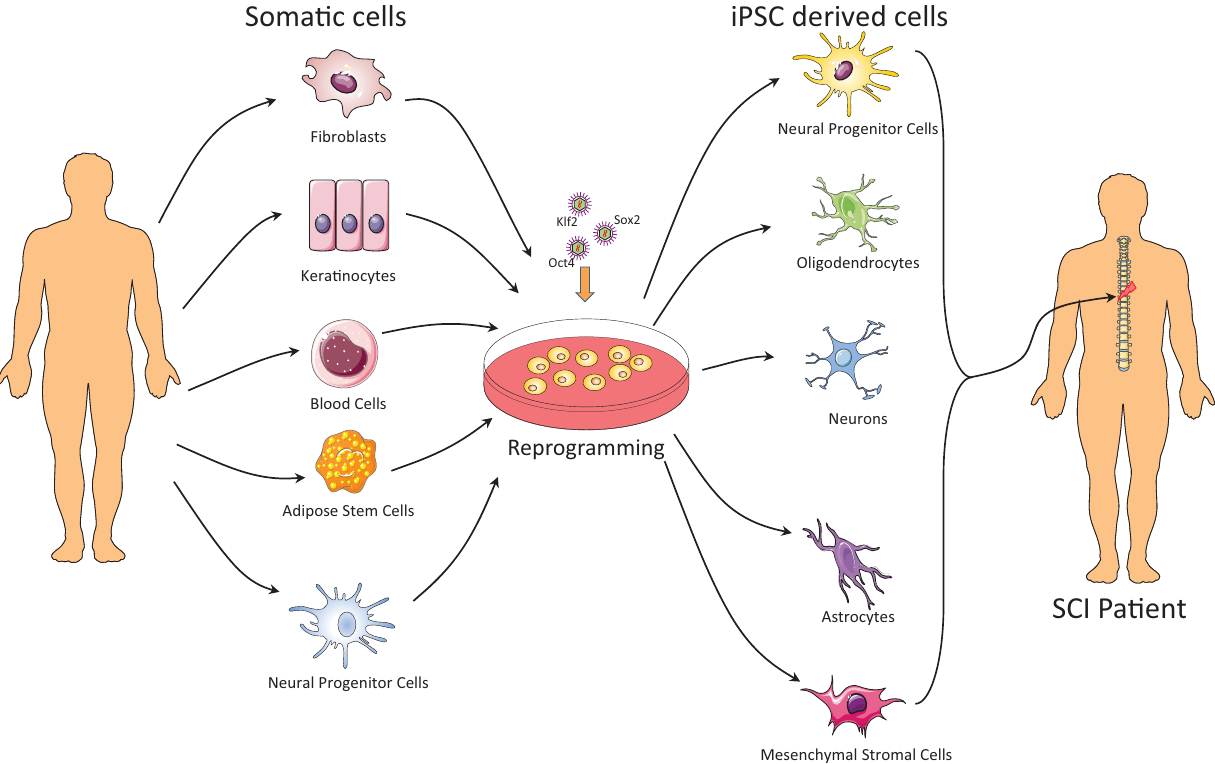
Figure 1. Several different types of cells have been used to produce iPSCs, including fibroblasts, neural progenitor cells, keratinocytes, melanocytes, CD34 + cells, cord